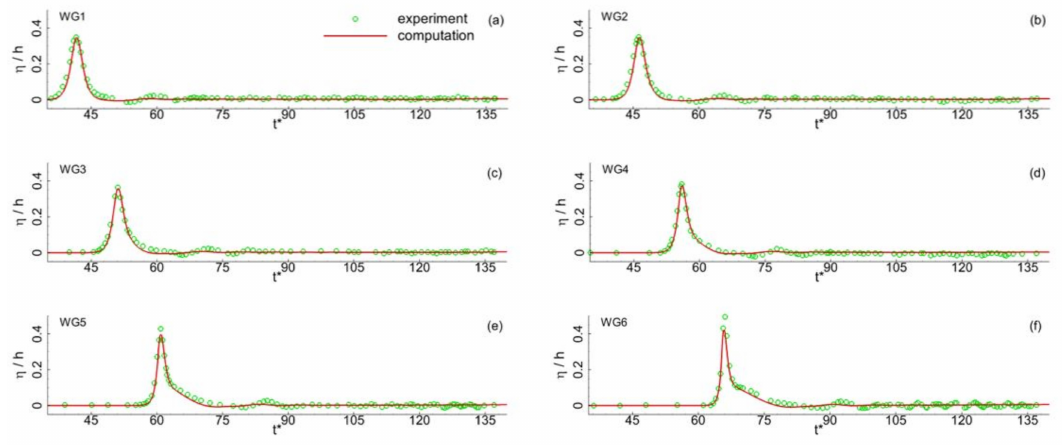
Figure 5. Comparisons of the time series of water surface elevation at different wave gauges for H / h = 0.208; ( a ) WG1; ( b ) WG2; ( c ) WG3; ( d ) WG4; ( e ) WG5; ( f ) WG6; ( g ) WG7; ( h ) WG8; ( i ) WG9; ( j ) WG10; ( k ) WG11; ( l ) WG12.